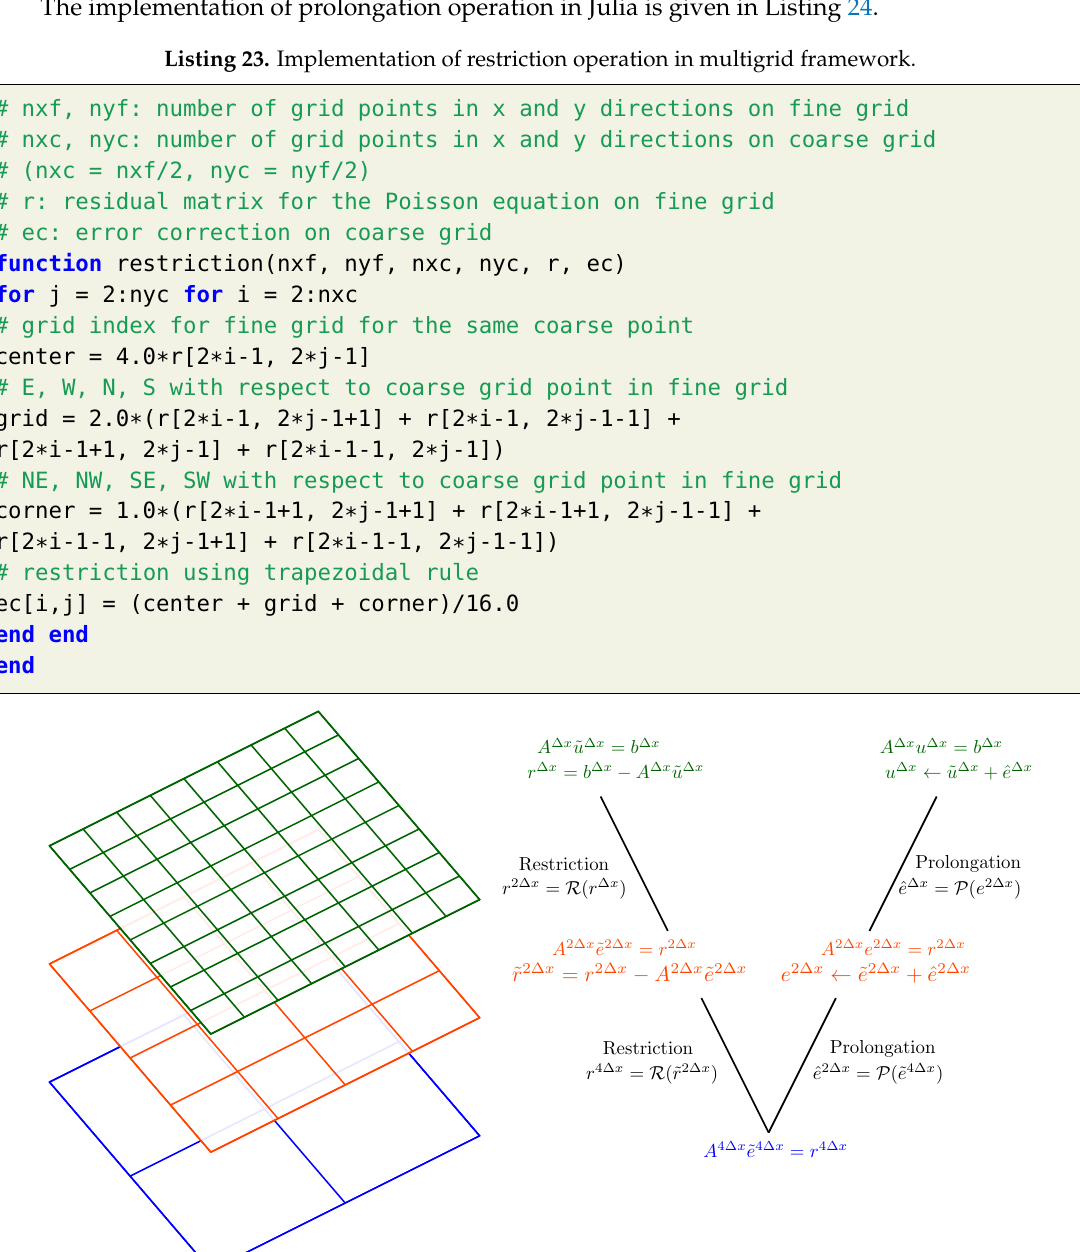
2 grid resolution and is solved ×